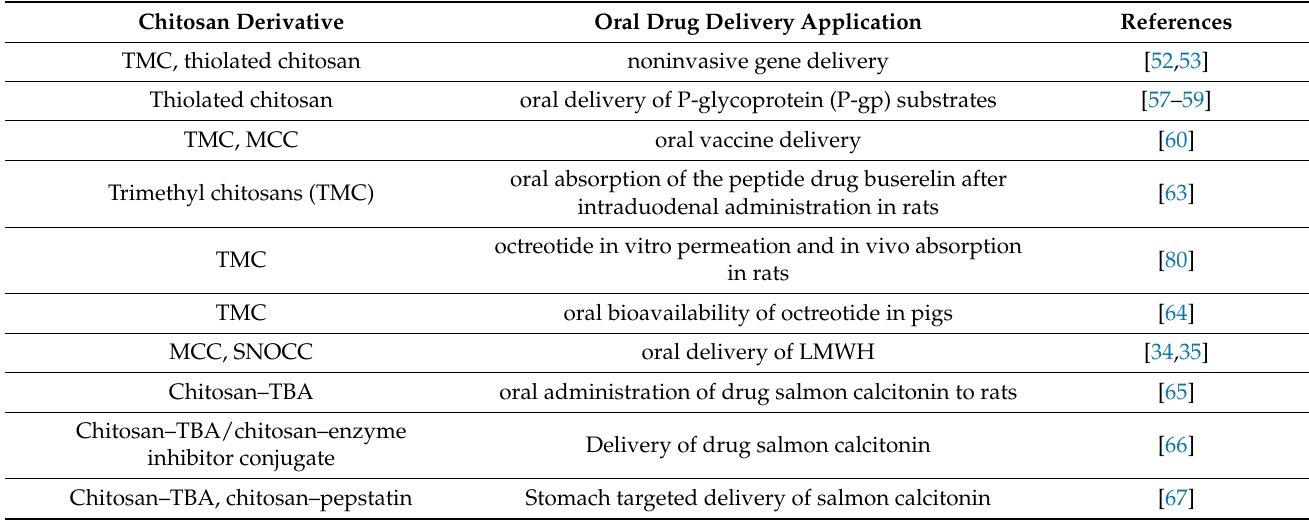
Table 1. Chitosan derivatives that have been used for oral drug delivery applications. Chitosan